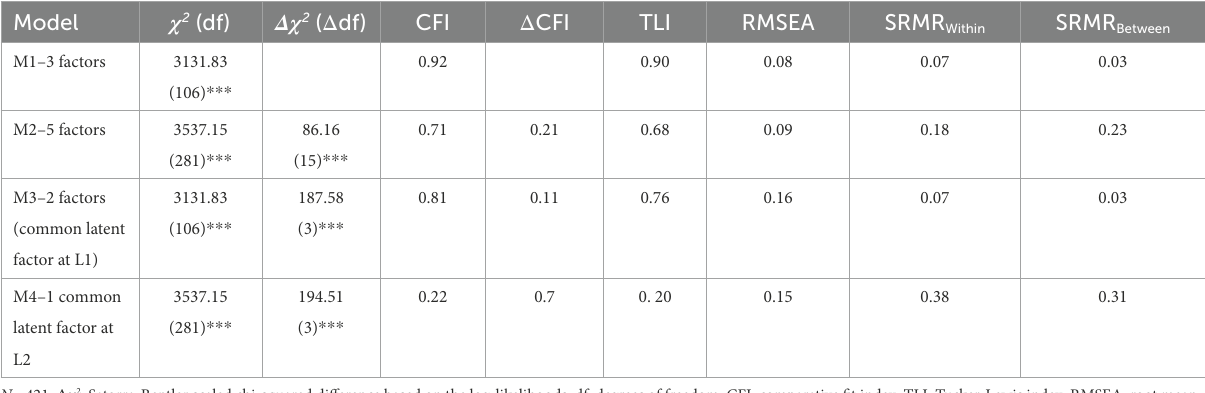
TABLE 1 Fit indices from the multilevel confirmatory factor analysis.